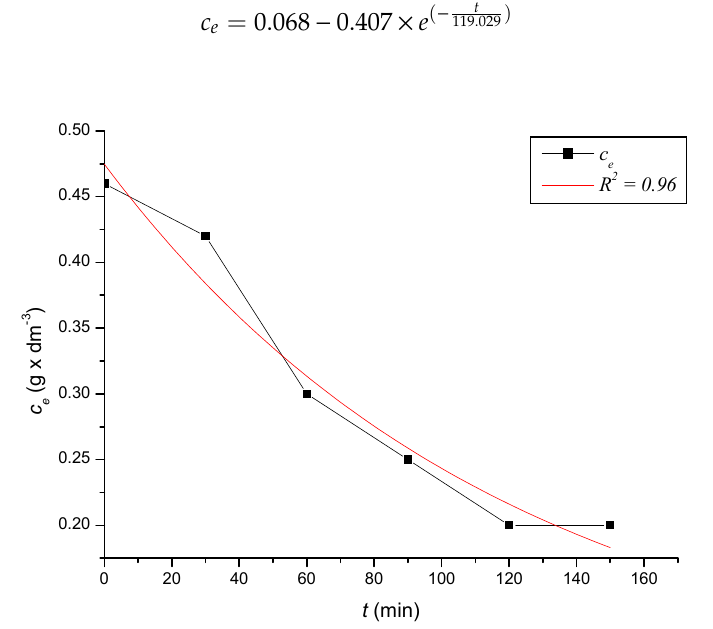
Figure 2. The kinetic course of reducing the concentration of Fe 3+ cations in a solution with an initial concentration of 0.46 g × dm −3 by the action of clinoptilolite.